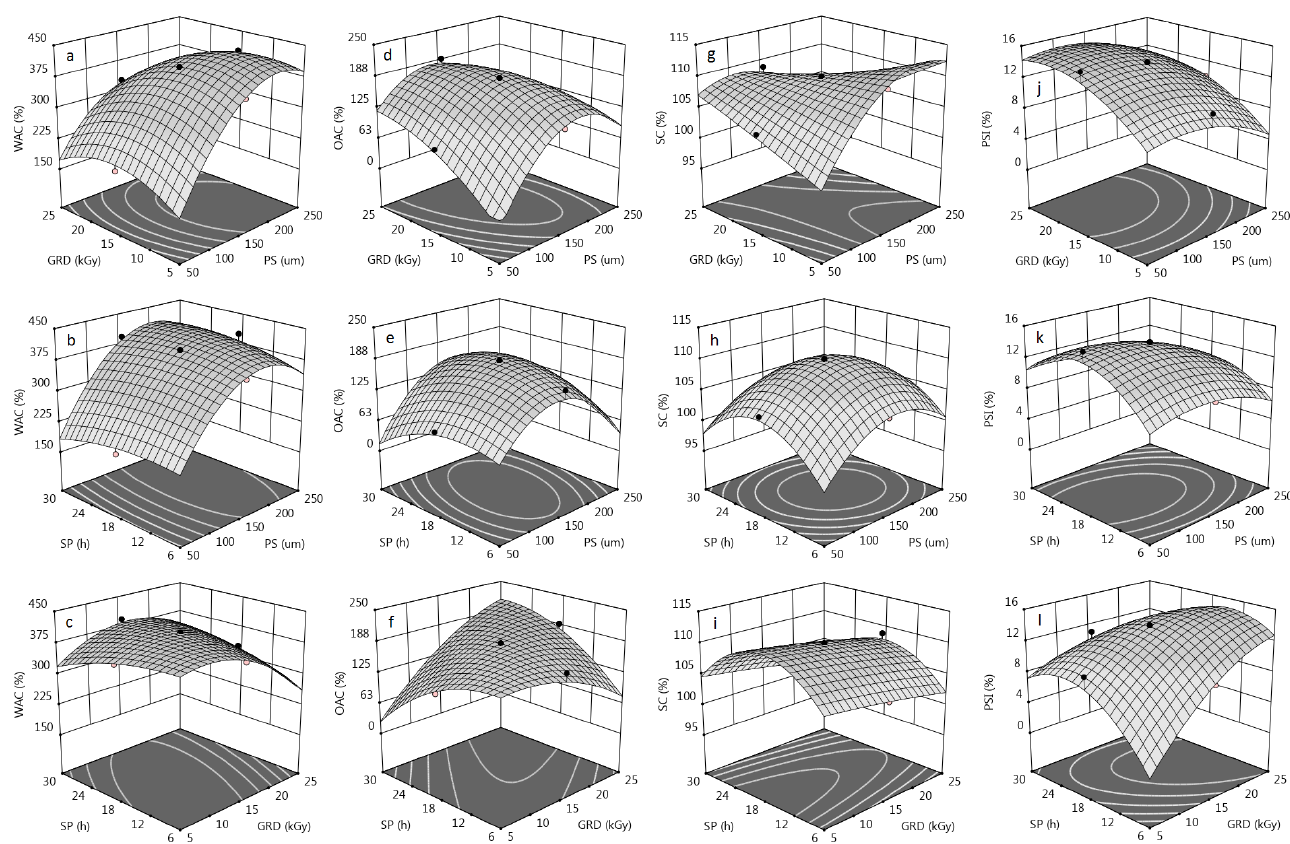
Fig. 1: Response-surface plots of functional properties of gamma-treated N. nucifera rhizome flour at selected levels of PS, GRD, and SP. a-c) WAC, d-f) OAC, g-i) SC, and j-l) PSI PS: Particle size, GRD: Gamma radiation dose, PS: particle size, WAC: water absorption capacity, OAC: Oil absorption capacity, SC: Swelling capac- ity, PSI: protein solubility